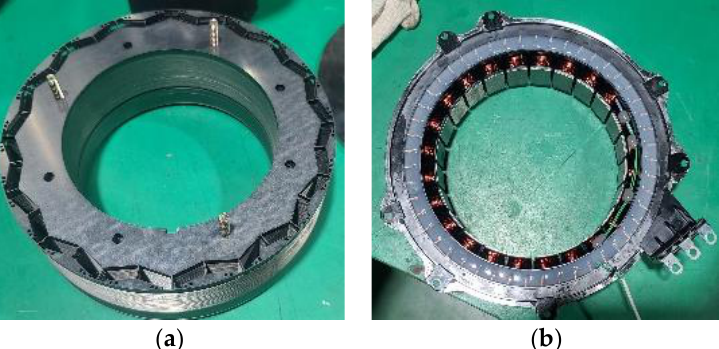
Figure 2. A rotor design process to reduce irreversible demagnetization and cogging torque: (a) rotor of conventional motor; (b) stator of conventional motor. Table 1. Specification of 35kW class hybrid traction motor with Dy-free magnet.